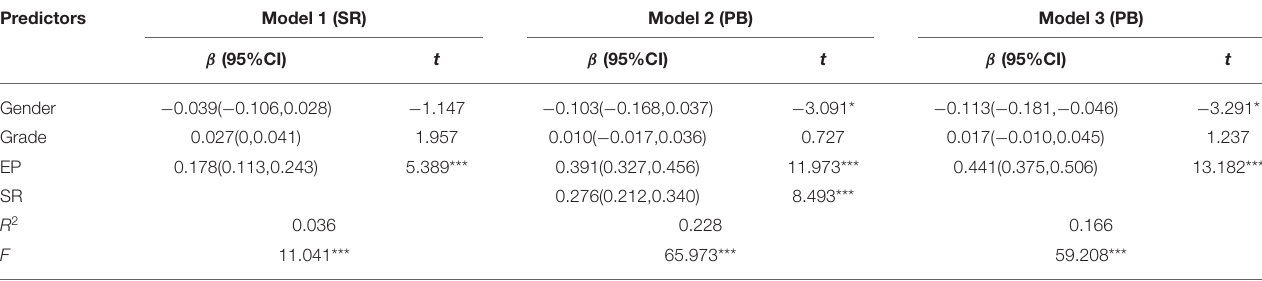
TABLE 2 | The results of regression analysis of variables in this study.